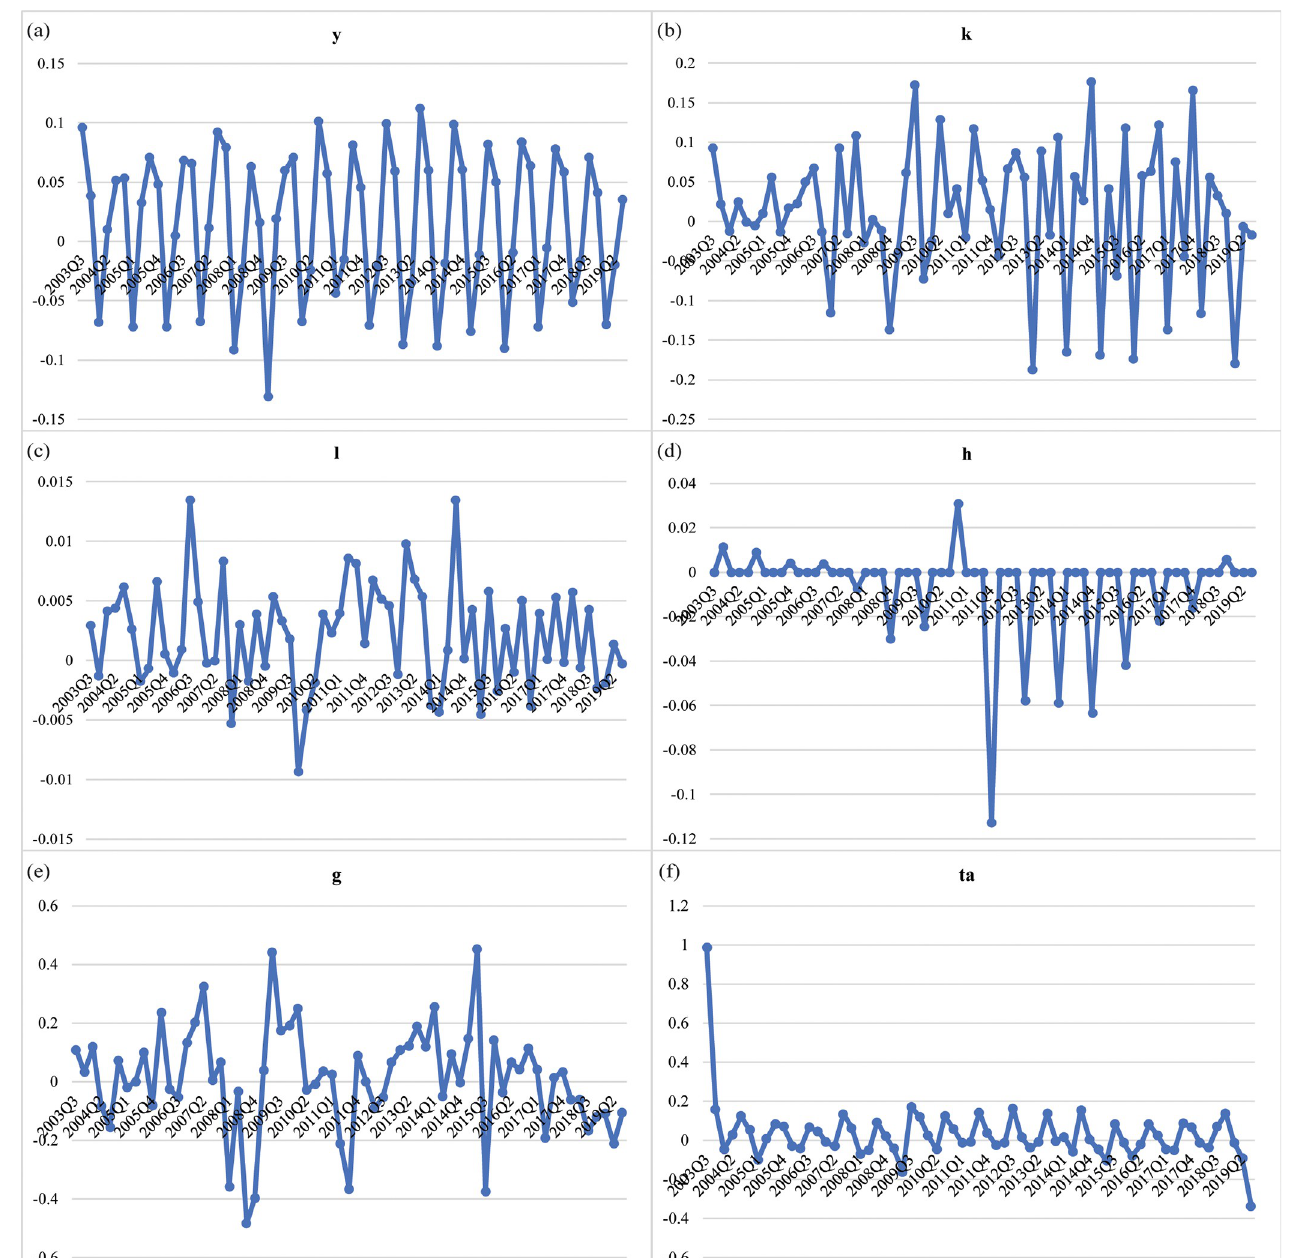
Fig 5. Trend charts of real GDP ( y ), physical capital ( k ), labor ( l ), human capital development ( h ), stock market capitalization of the Growth Enterprise Market ( g ), and the number of international tourism arrivals ( ta ).